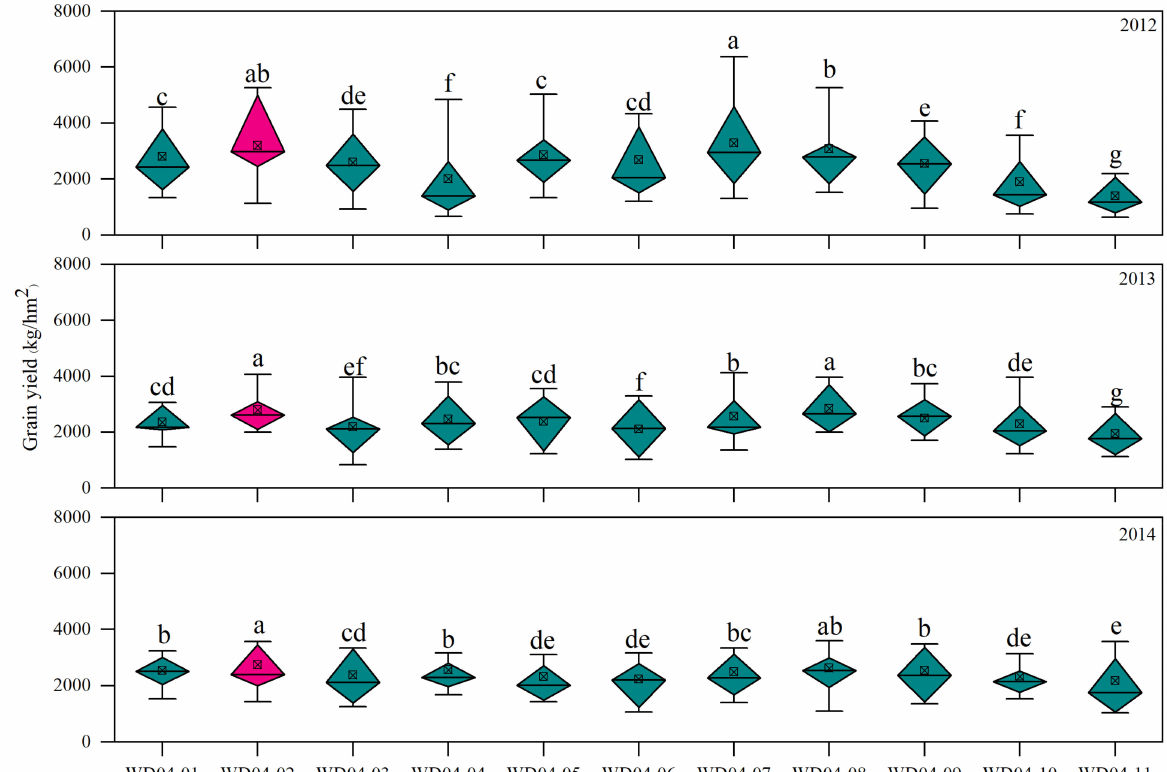
Figure 5. Grain yields of the fourth round of regional trials of China pea cultivars in the spring sowing group. The different lowercase figures above indicate significant differences between treatments ( p =